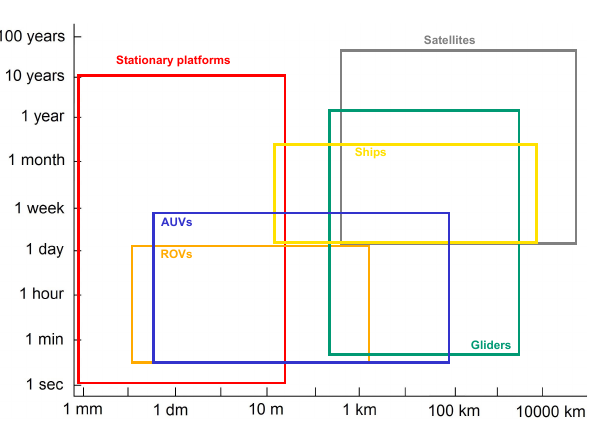
Figure 2: Spatial and temporal scales and resolutions of different sensor platforms. Figure is based on Strommel diagram in (Nilssen et al., 2015). Left/lower part of a box means res- olution, while the right/upper part of a box means scale. Note that the scale of the axes are nonlinear, and the numbers are only for providing an indication.